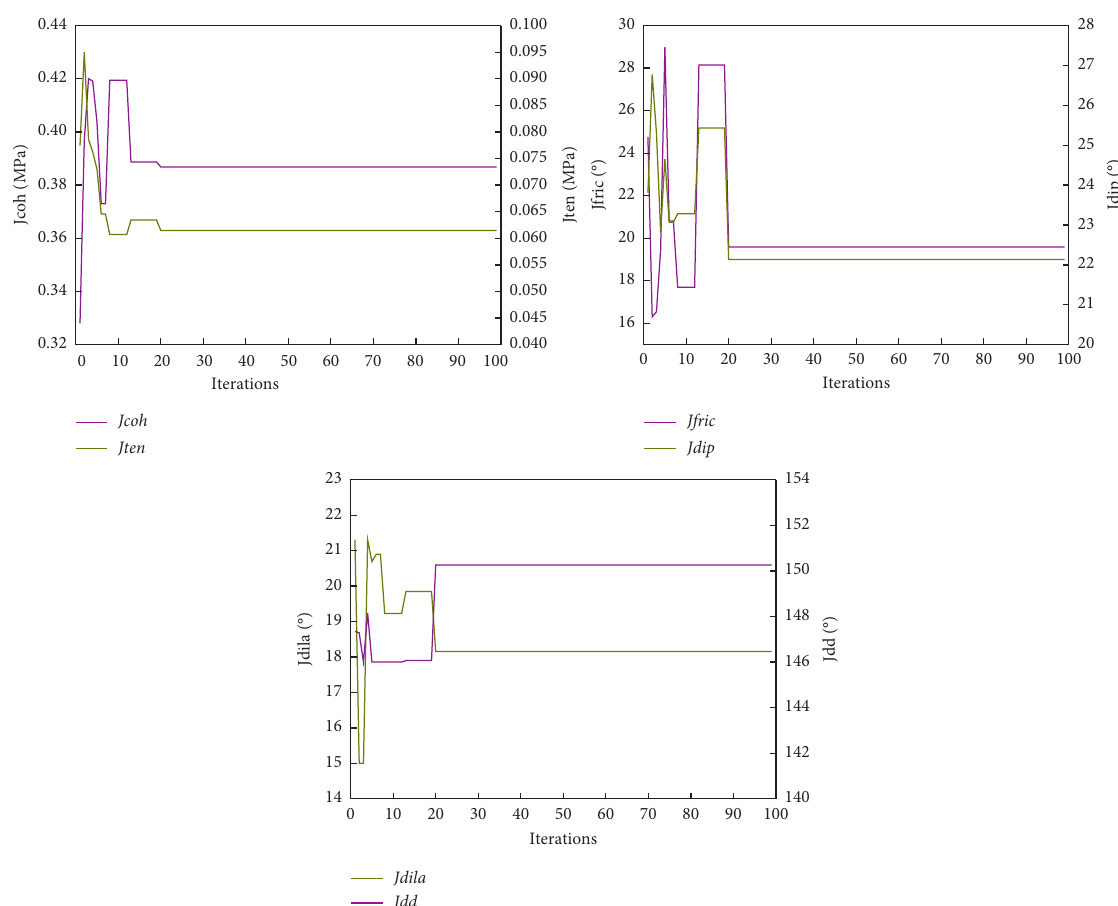
Figure 6: Optimization process of parameters ( jcoh , jten , jfric , jdip , jdila , and jdd ).